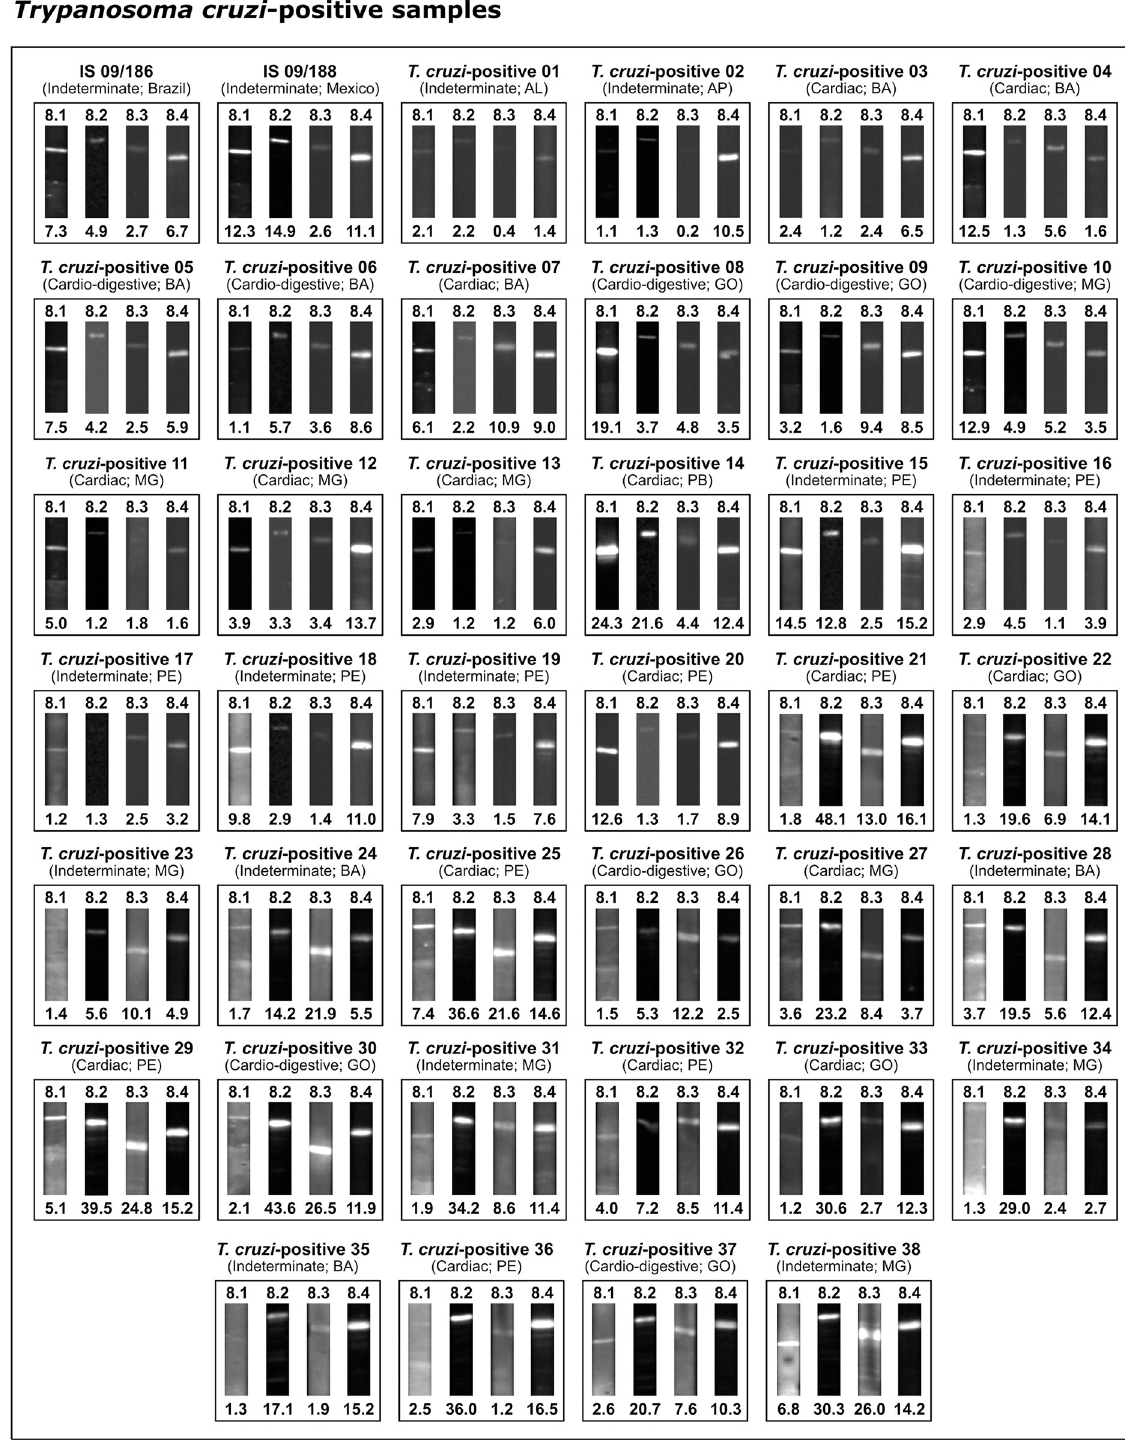
Fig 3. Photographic images of nitrocellulose test strips result from Trypanosoma cruzi -positive samples. Relative band intensity (RBI) values respective to each IBMP antigen are shown below the images pertaining to each sample. Abbreviations: AL (Alagoas); AP (Amapa´); BA (Bahia); GO (Goia´s); MG (Minas Gerais); PE (Pernambuco).